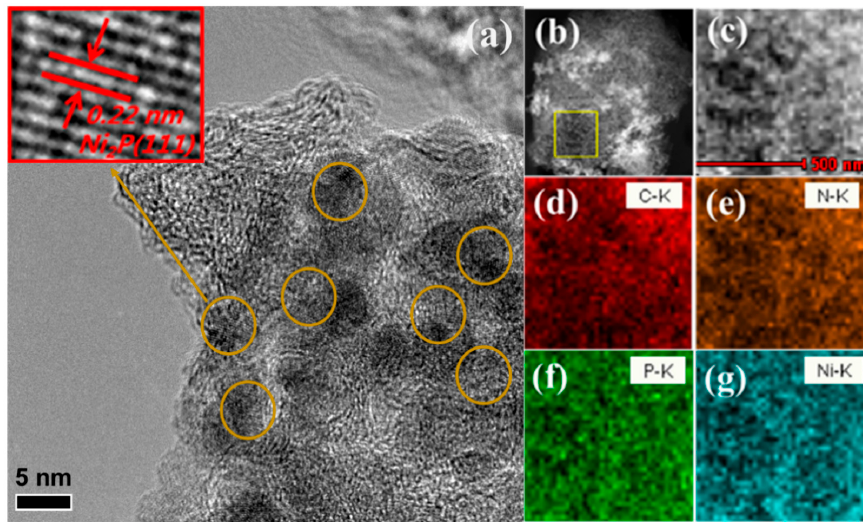
Figure 2. High resolution transmission electron microscopy (HRTEM) image ( a ) and energy dispersive X-ray spectroscopy (EDS) elemental mapping images ( b – g ) of Ni 2 P/NC-60.